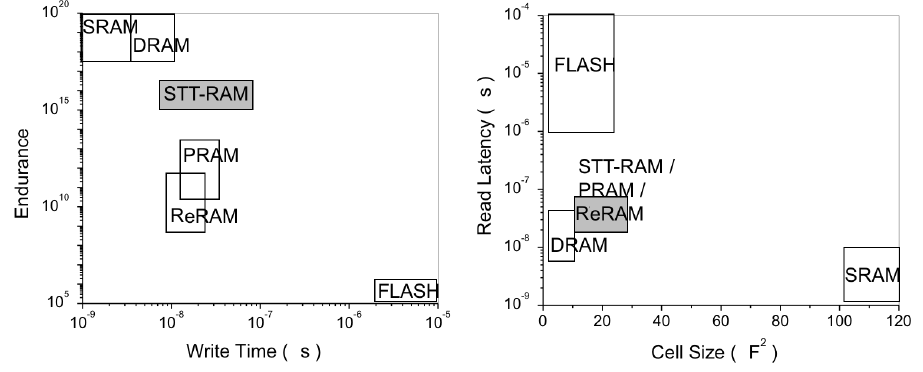
Figure 8. Performance comparison of memory devices.